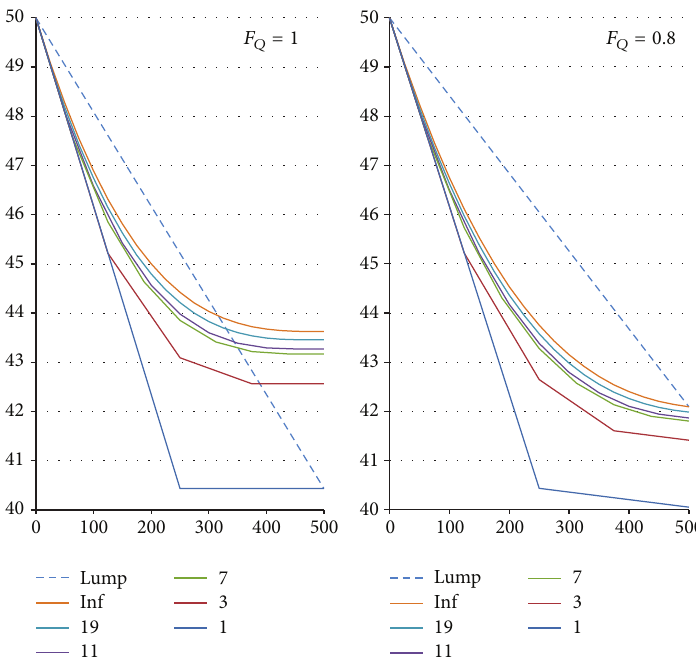
Figure 2: Examples of discrepancy between distributed and lumped demand